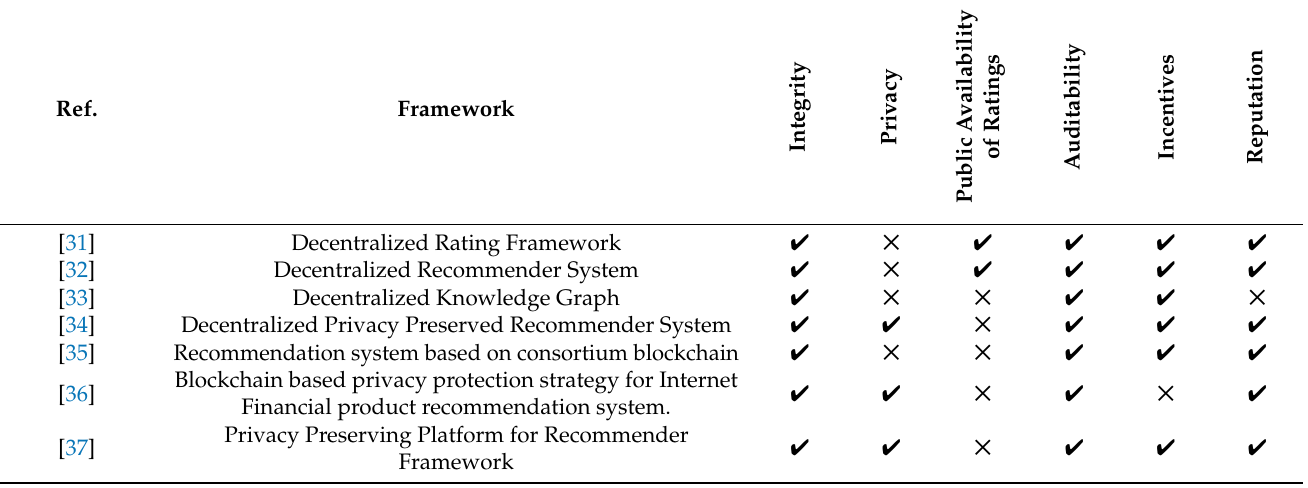
Table 14. Blockchain for AI based recommender systems.